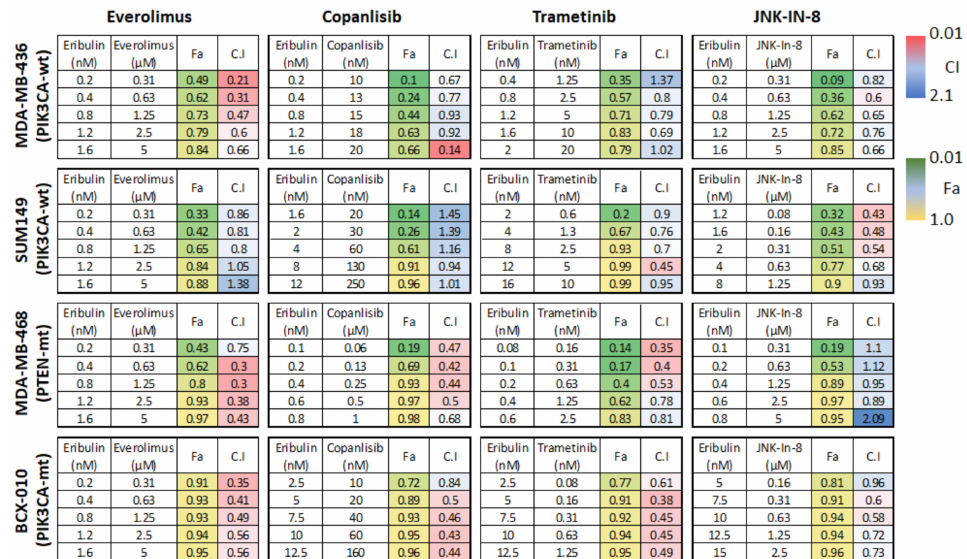
Figure 3. Fraction affected (Fa) and combination index (CI) of eribulin combined with other drugs in TNBC cell lines. CIs indicate the following: <0.1, very strong synergism; 0.10–0.30, strong synergism; 0.31–0.70, synergism; 0.71–0.85, moderate synergism; 0.86–0.90, slight synergism; 0.91–1.10, nearly additive; 1.11–1.20, slight antagonism; 1.21–1.45, moderate antagonism; 1.46–3.30, antagonism; 3.31– 10, strong antagonism; >10, very strong antagonism. Fa 1.0 indicates 100% cell death. mt,